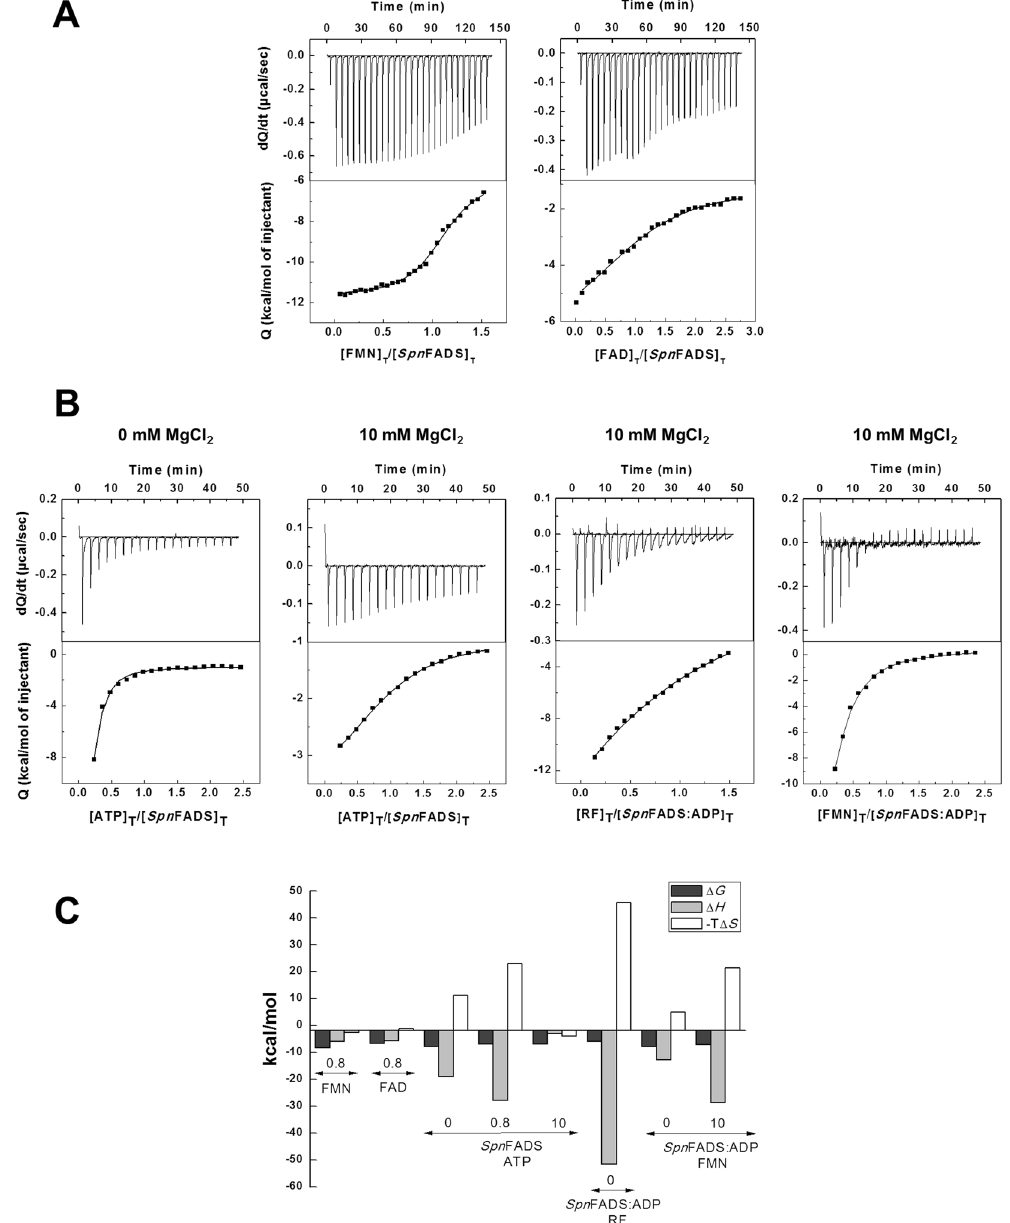
Figure 2. Binding of ligands to Spn FADS. ( A ) Calorimetric titrations of SpnF ADS with reduced FMN and FAD, performed at 20 °C in 20 mM PIPES, pH 7.0, 0.8 mM MgCl 2 , 4 mM sodium dithionite, 10 mM glucose, 0.5 U/mL glucose oxidase (degassed). ( B ) Calorimetric titrations of SpnF ADS with ATP and of the preformed Spn FADS:ADP complex with RF or FMN, at 20 °C in 20 mM PIPES, pH 7.0, and at the indicated concentrations of MgCl 2 . In all titration figures upper panels show the thermograms for the interactions and the lower panels show the corresponding binding isotherms with integrated normalized heats. ( C ) Thermodynamic dissections of the interaction of Spn FADS with reduced FAD, reduced FMN and ATP, as well as of the preformed Spn FADS:ADP complex with RF and FMN. The binding Gibbs energy ( Δ G ), enthalpy ( Δ H ), and entropy (-T Δ S ) are represented in dark grey, light grey and white bars, respectively. MgCl 2 concentrations in mM used in each experiment are indicated by